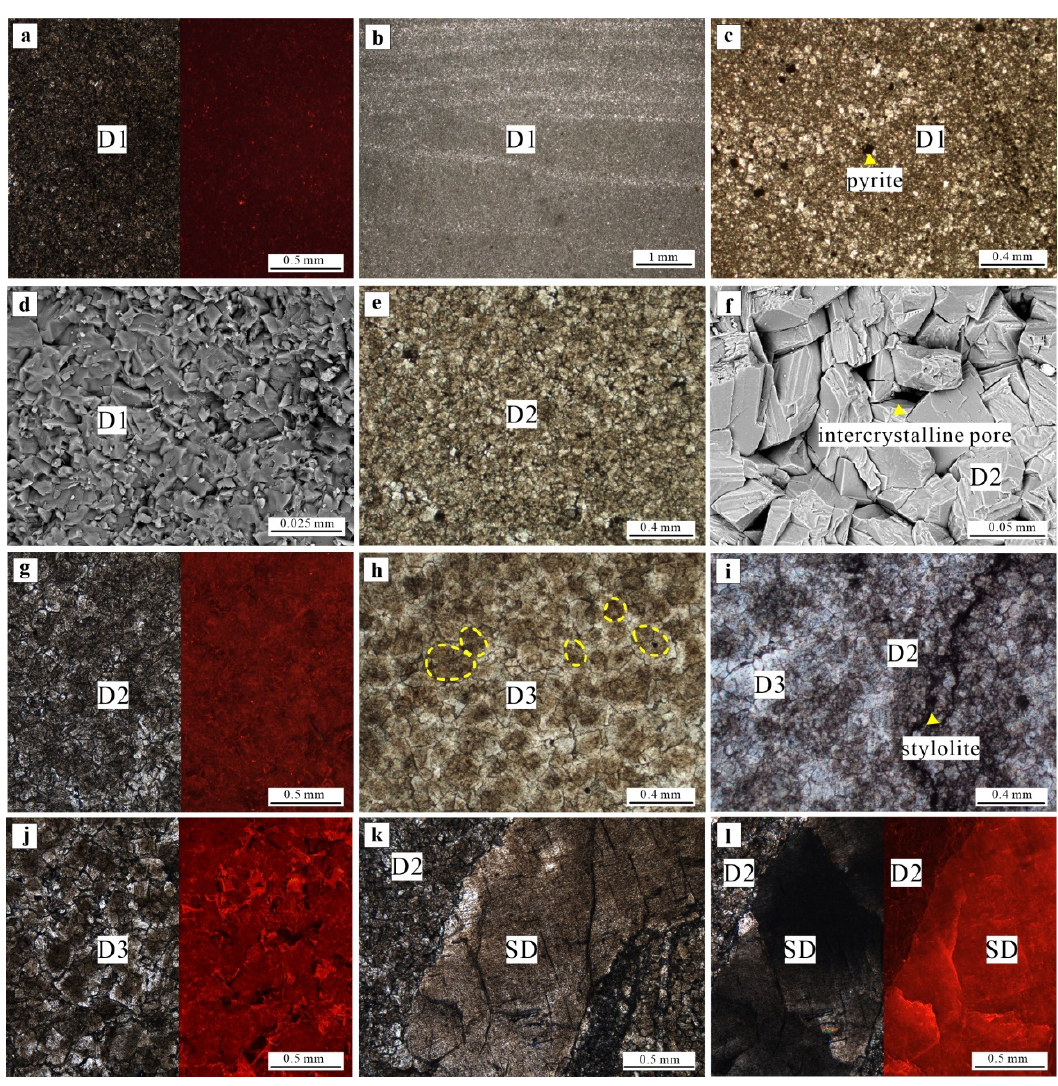
Figure 2. Petrographic characteristics of the recognized dolomite generations in the Xixiangchi Formation. ( a ) Thin section images of D1 under PPL (left) and CL (right) displaying non to very weak dull luminescence. ( b ) D1 dolomite with horizontal to low-angle algel laminas, PPL. ( c ) Pyrites with a shape of cubic grain (yellow arrow) were discretely distributed within D1. ( d ) Dolomite D1, tightly compacted planar-s to planar-e crystals of D1 under SEM. ( e ) D2 with dirty crystal surfaces under PPL. ( f ) Planar-s crystals of D2 and associated intercrystalline pores (yellow arrow), SEM. ( g ) Microscopic images of D2 under PPL (left) and CL (right) exhibiting mottled dull-red luminescence. ( h ) Mosaic textures, dirty crystal surfaces and grain ghosts (yellow dotted lines) of D3 under PPL. ( i ) Crystals of D2 and D3 are truncated by stylolite (yellow arrow) under PPL. ( j ) Microscopic images of D3 under PPL (left) showing cloudy core and clear rims, and under CL (right) displaying mottled dull-red luminescence. Note the coarser crystals than D1 and D2 dolomites. ( k ) SD cements filling the fractures in the dolomite D2, PPL. ( l ) Microscopic images of SD cements under XPL (left) and CL (right), showing undulatory extinctions and brighter red luminescence, respectively.